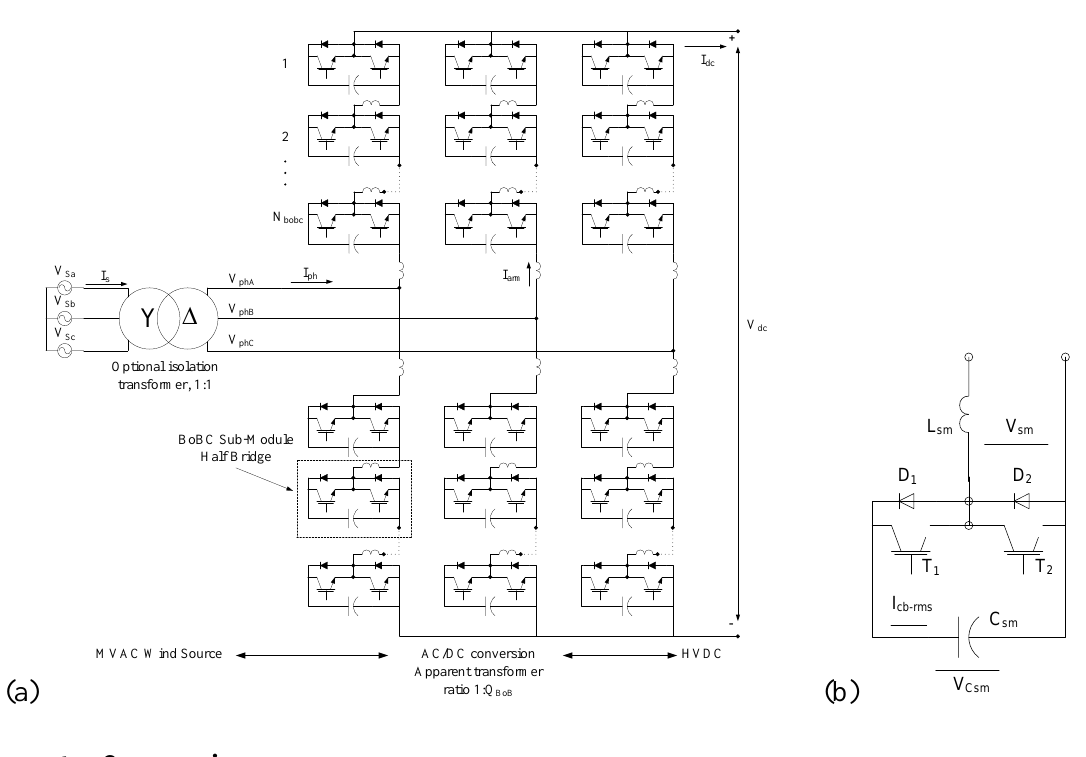
Figure 4. (a) Simplified BoBC schematic for HVDC realization (b) Simplified BoBC sub-module schematic, half bridge